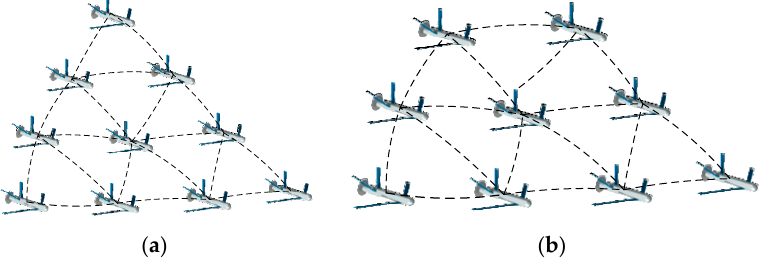
Figure 1. Schematics of typical Structure 1.